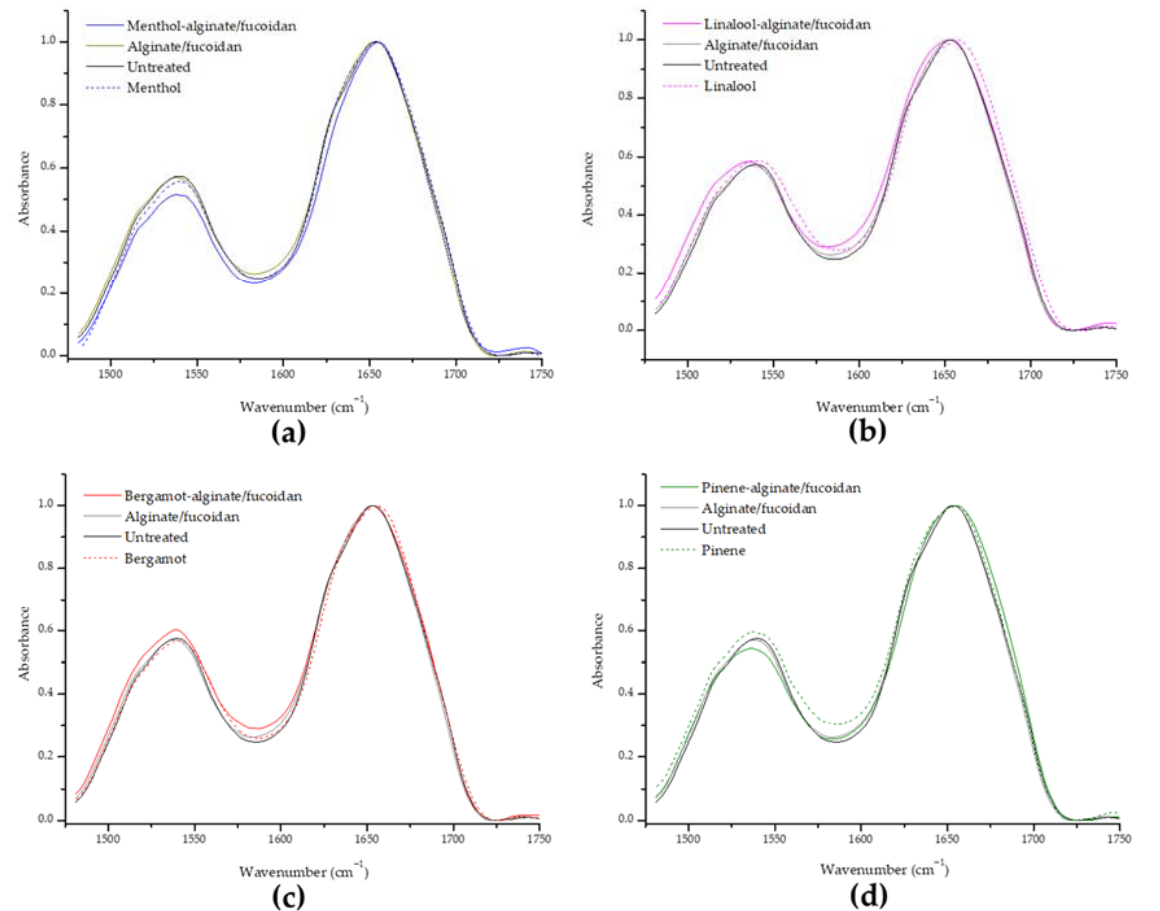
Figure 6. Evaluation of the amide I and amide II keratin band shifts in all essential oils and essential-oil-enriched hydrogels in comparison to the untreated sample, organized as menthol- alginate/fucoidan ( a ), linalool-alginate/fucoidan ( b ), bergamot-alginate/fucoidan ( c ), and pinene- alginate/fucoidan ( d ).